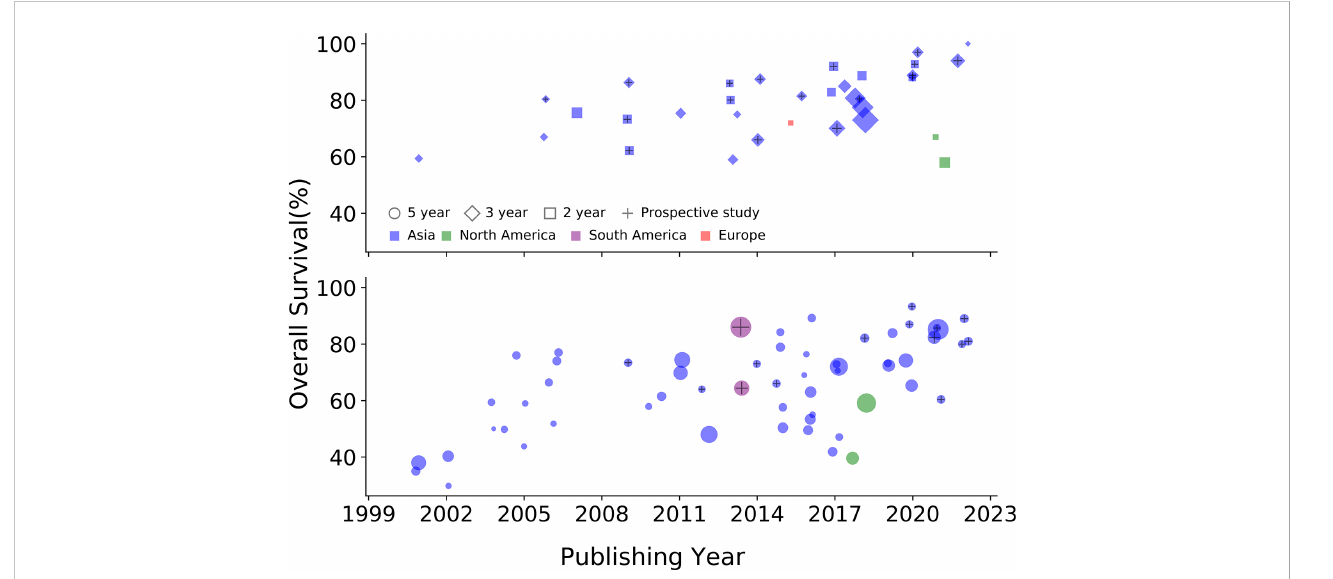
FIGURE 2 Survival trends of patients with Ann Arbor stage I/II ENKTCL over the past two decades. Only data from patients treated with RT or RT plus CT are included. The area of each marker in the fi gure indicates the sample size of the study. Data are cited from (27 –